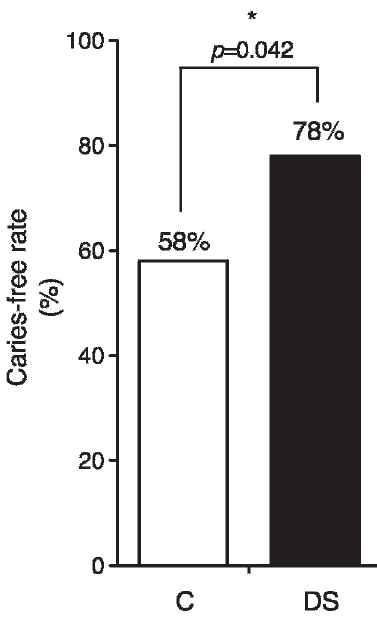
Figure 1 - The caries-free rates of Down syndrome (DS) children and sibling controls (C). The bars represent the means, and error bars represent the SDs. p -value was calculated using the chi- square test. *Values are significantly different between DS and sibling controls.